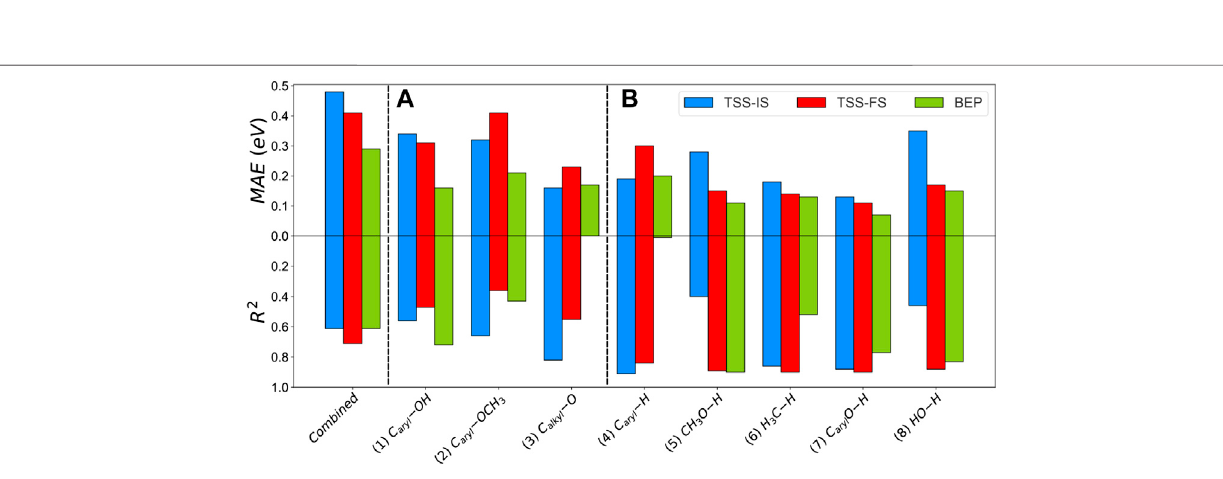
Frontiers in Catalysis |